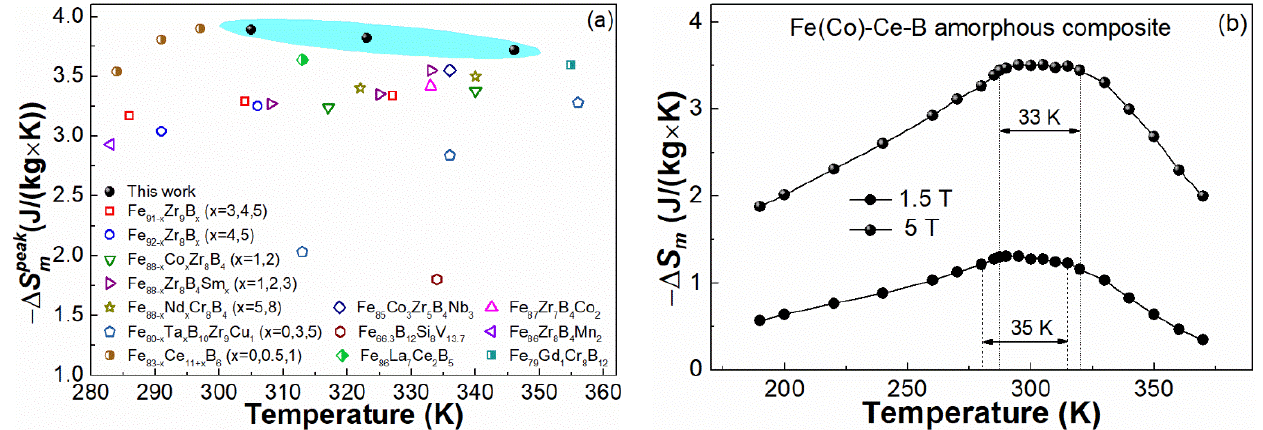
Figure 5. ( a ) −Δ S mpeak of various Fe-based metallic glasses with T c ranging from 280 K to 360 K under 5 T; ( b ) table-like ( −Δ S m )- T plots of the amorphous composite composed of Fe(Co)-Ce-B amorphous ribbons under 1.5 T and 5 T.